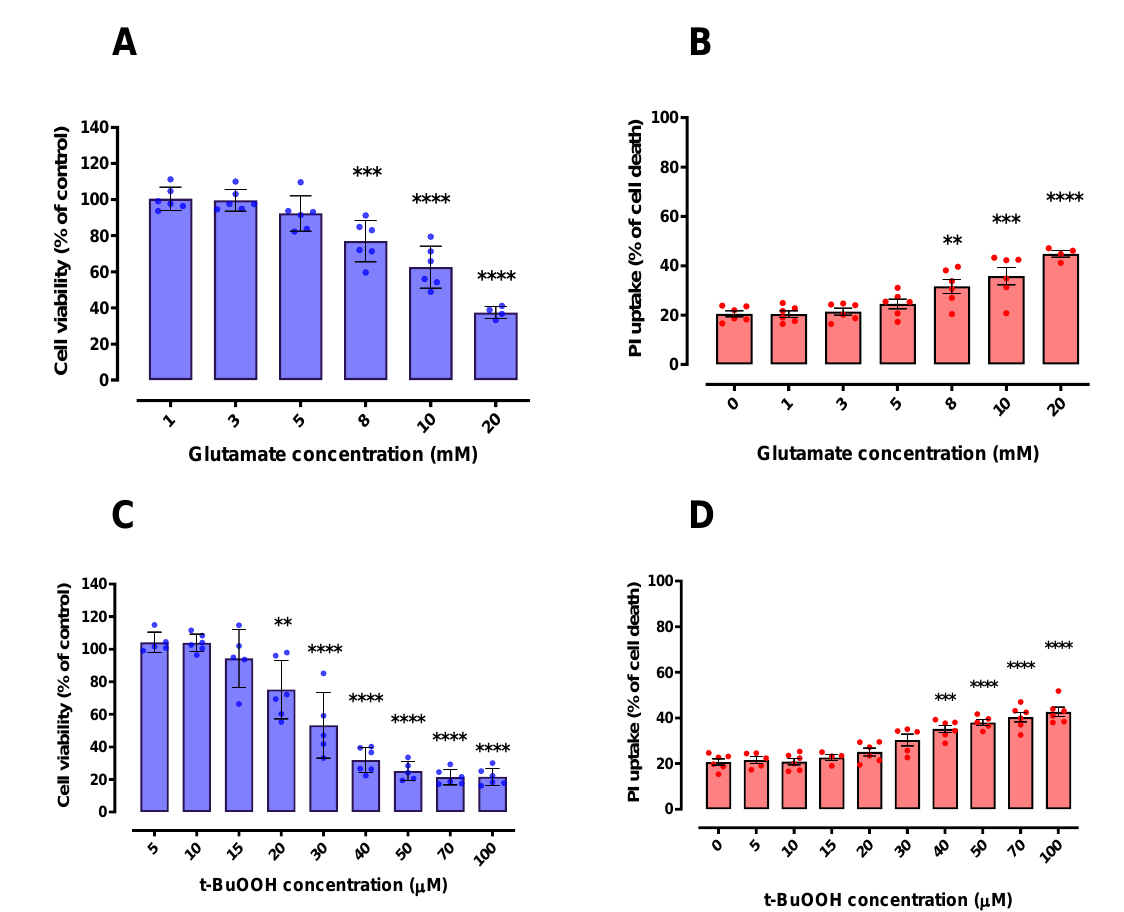
Figure 3. Effects of Glutamate and t -BuOOH on HT22 cell viability. HT22 cells exposed to glutamate ( A , B ) and t -BuOOH ( C , D ) exhibited a progressive (concentration-dependent) impairment of cell viability in both tested methodologies (MTT and PI). In ( B , D ), 100% cell death is represented by cells treated with 0.2% Triton X-100 for 20 min. ** p < 0.01; *** p < 0.001; **** p < 0.0001 compared to control group (untreated cells). n =